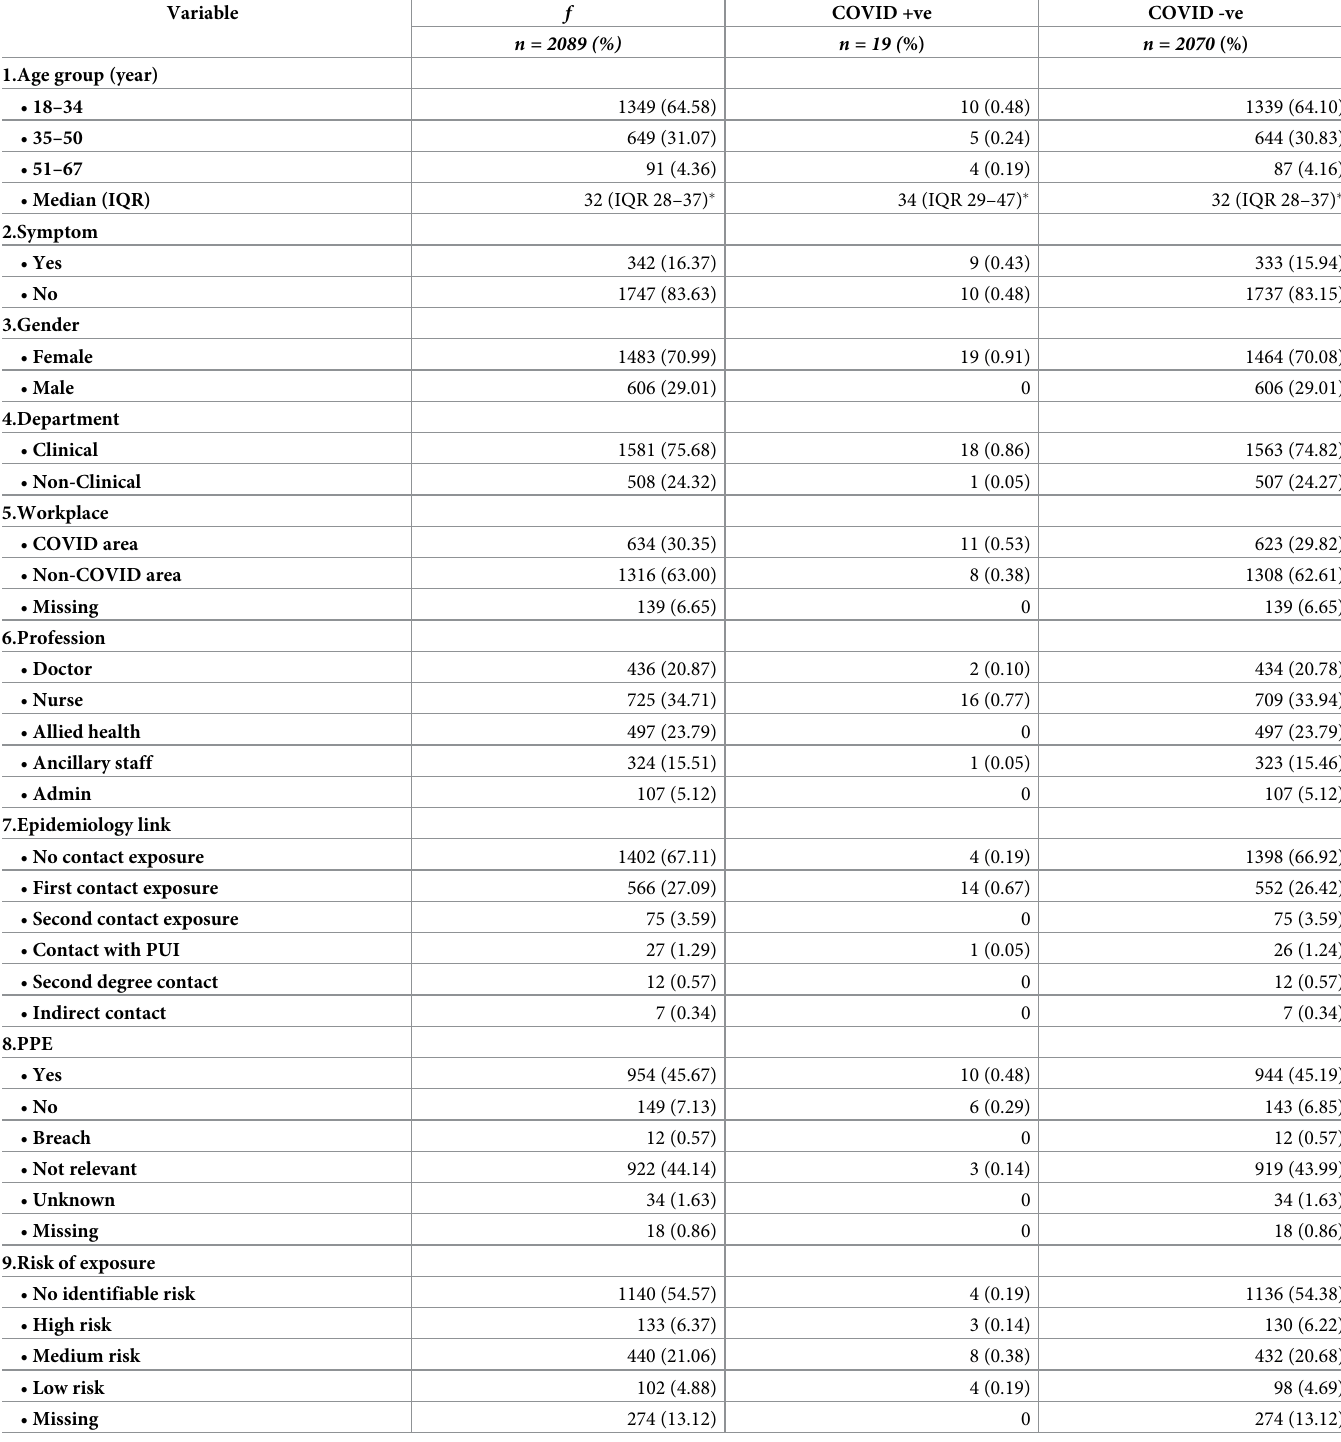
Table 1. Demographic characteristics of the